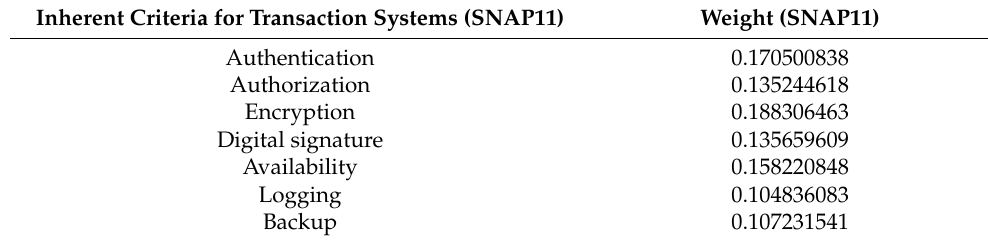
Table 7. Criteria weights of inherent elements for transaction systems obtained by SNAP11.